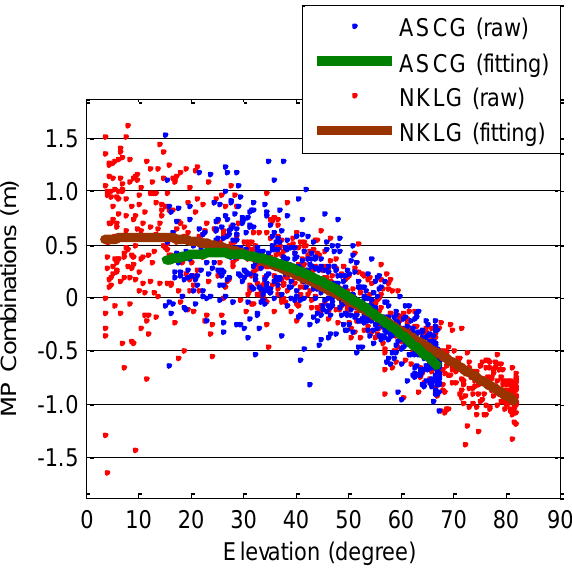
Figure 5. Dependence of MP combination time series of B1 signal on elevations for BDS-2 MEO satellite C14 at stations ASCG and NKLG on 19 August 2016.